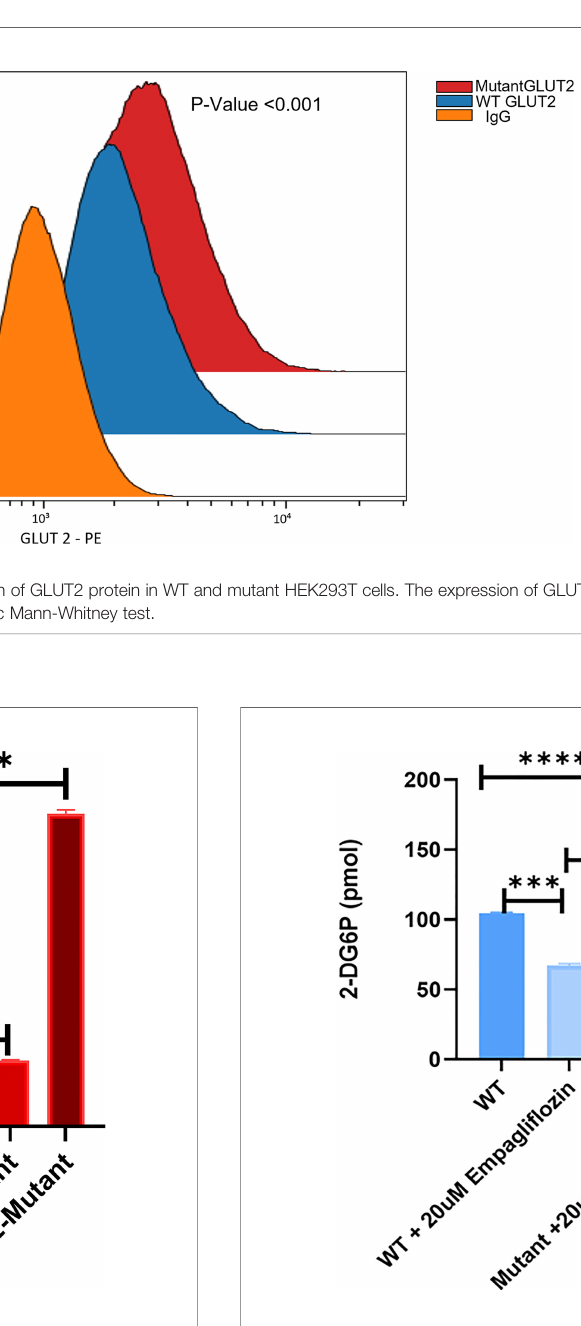
FIGURE 6 | qRT-PCR to assess the expression of other glucose transporters in HEK293T. GLUT2 mutation stimulates the expression of SGLT2. Signi fi cant induction of SGLT1 and SGLT2 in mutant cells in comparison to WT cells. Down-regulation of GLUT1 expression in mutant cells in comparison to WT cells. P-value was calculated using two-tailed t-test and presented with a ‘‘ * ’’ in the graph. **P values less than 0.01; ***P values less than 0.001.